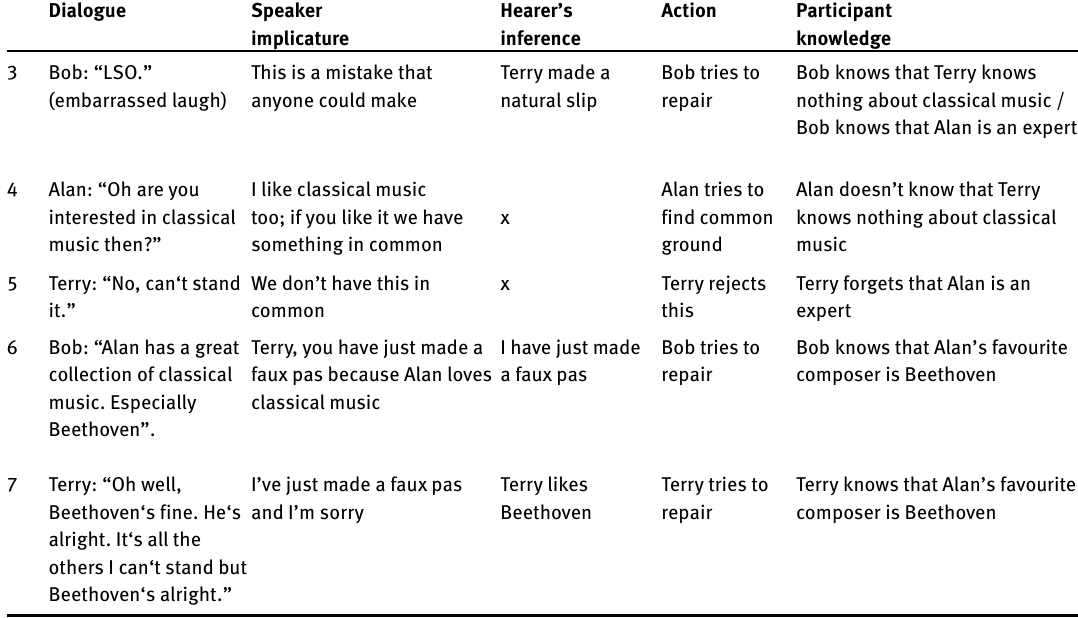
Table 2: ‘Guess who’s coming to dinner’, extract 2 Dialogue Speaker